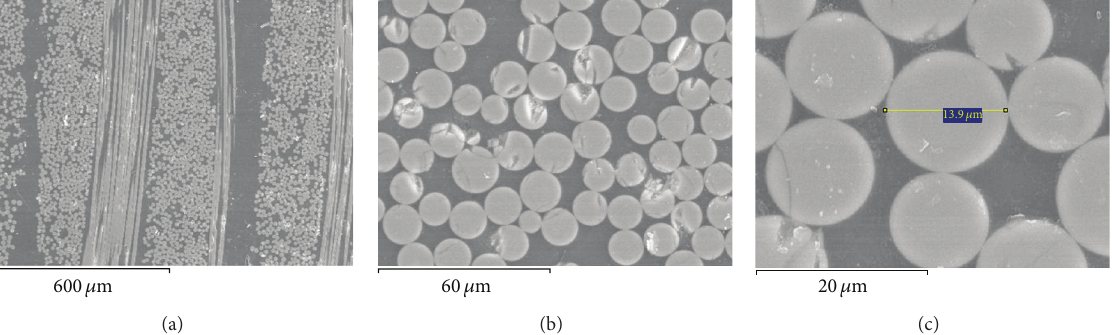
Figure 14: SEM micrograph taken from the polymerized samples showing complete fiber impregnation and the absence of voids. 391.6 250.0 226.7 203.3 180.0 156.7 133.3 110.0